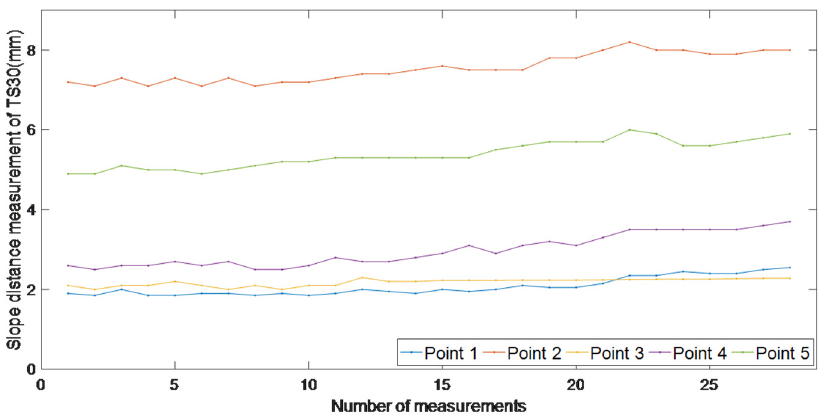
Figure 4. The fluctuation diagram of the slope distance measurements of TS30.